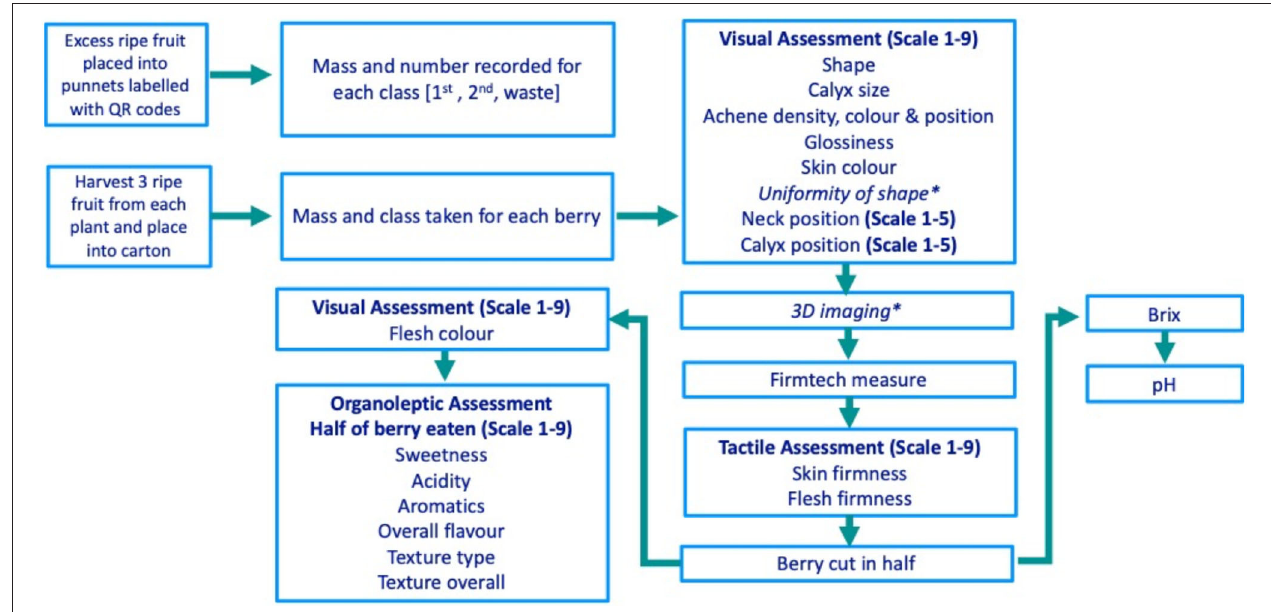
FIGURE 1 | The strawberry phenotyping process from the picking of strawberries through to destructive assessments. Each box represents a discrete phenotyping station * Uniformity of shape and 3D imaging have been reported by Li et al.